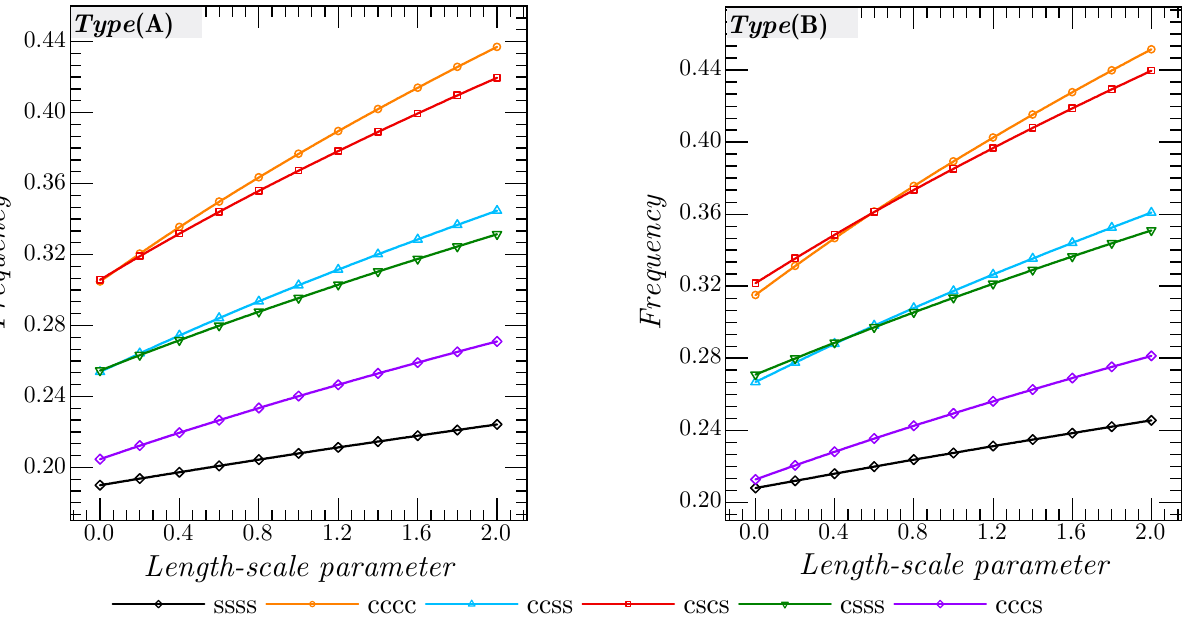
Figure 11. Effect of length-scale parameter on the dimensionless frequency of spherical shell for various boundary conditions ( FG − X , N = 10 V ∗ cnt = 0.17, p = 1, µ = 0 )